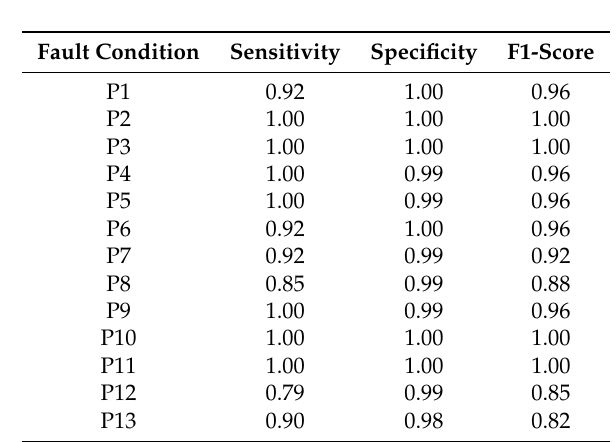
Figure 21. Confusion matrix for CCM features and EBT. Table 3. Results for the EBT model using features extracted from signals recorded with the accelerometer A3.